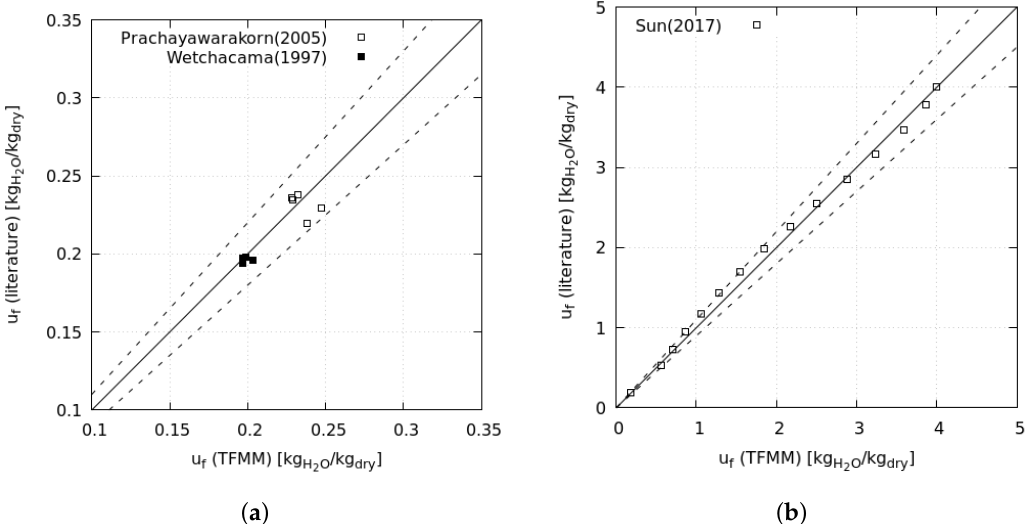
Figure 6. Value of u f under off-design conditions of rice ( a ) and MSS ( b ); values on the dot lines present the prediction error of ±